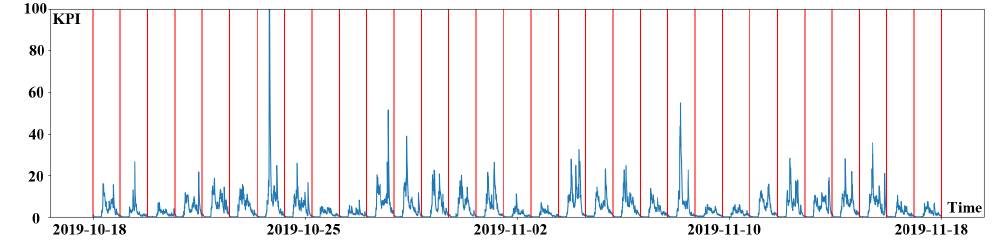
Figure 5. Sub-sequences segmentation of KPI time series